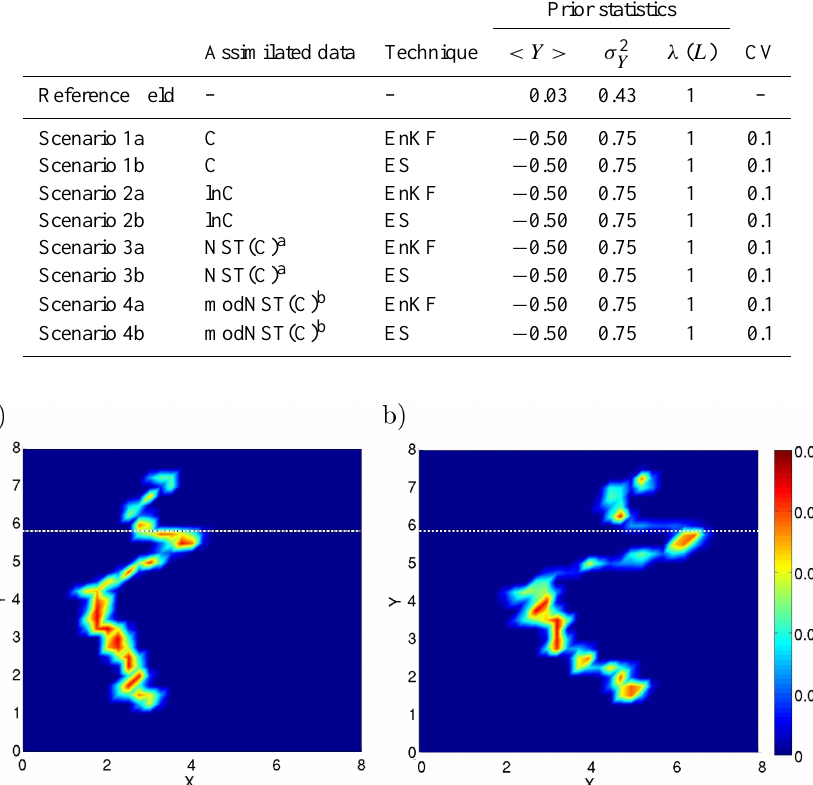
Fig. 3. Scenario 1: log-transformed hydraulic conductivity field retrieved by a) the EnKF and b) ES using untransformed concentration data. The color bar indicates log-transformed hydraulic conductivity in ln( L/T ). Panels c) and d) show the estimation variance maps after the inversion for the EnKF and ES, respectively.